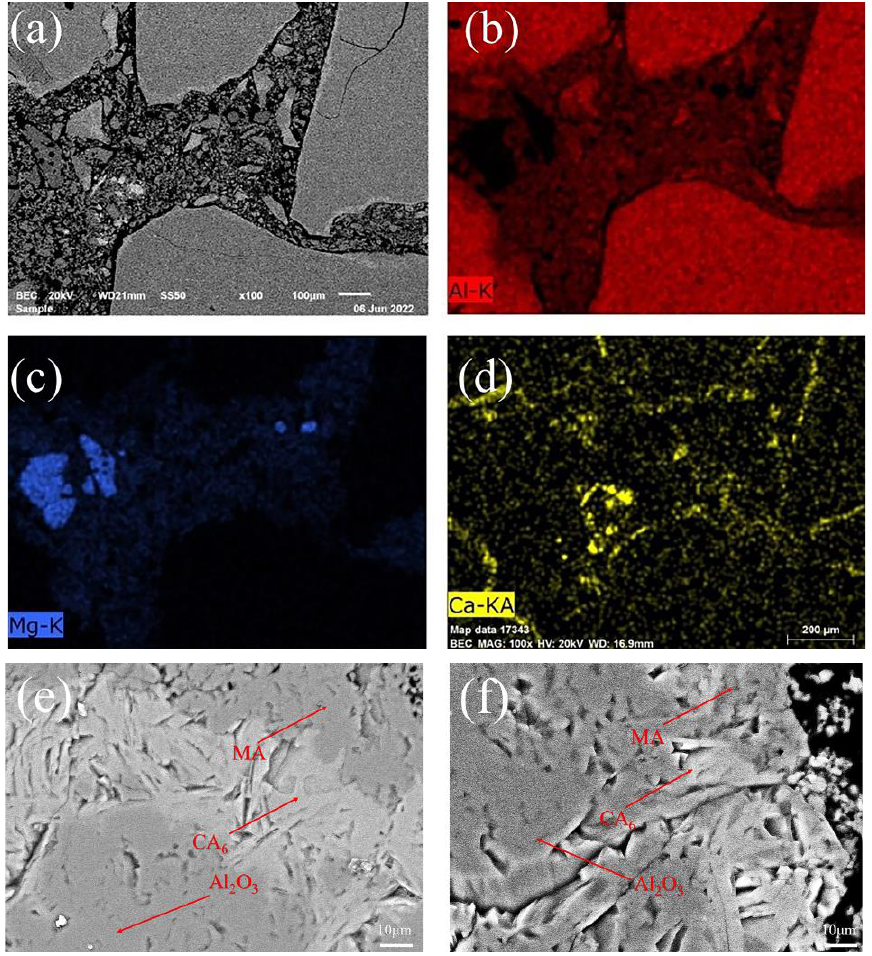
Figure 5. EDS mapping of sample G8 ( a ) image, ( b ) Al, ( c ) Mg, and ( d ) Ca and local magnified SEM images of samples G4 ( e ) and G8 ( f ) after sintering at 1600 °C for 3 h.